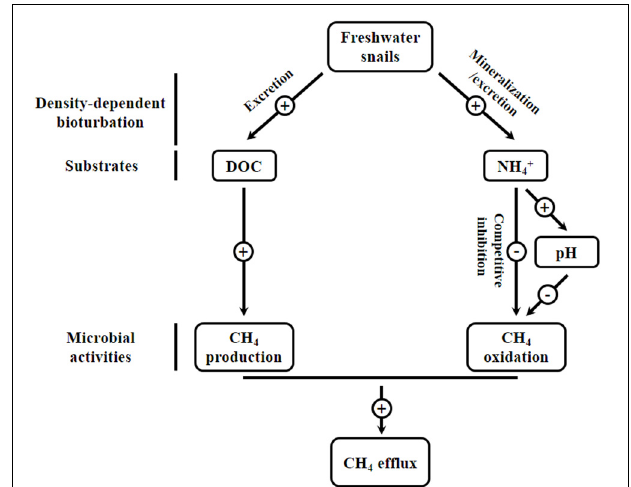
FIGURE 4 | Schematic presentation of the possible mechanisms of freshwater snail effects on the CH 4 cycling in the investigated freshwater lake